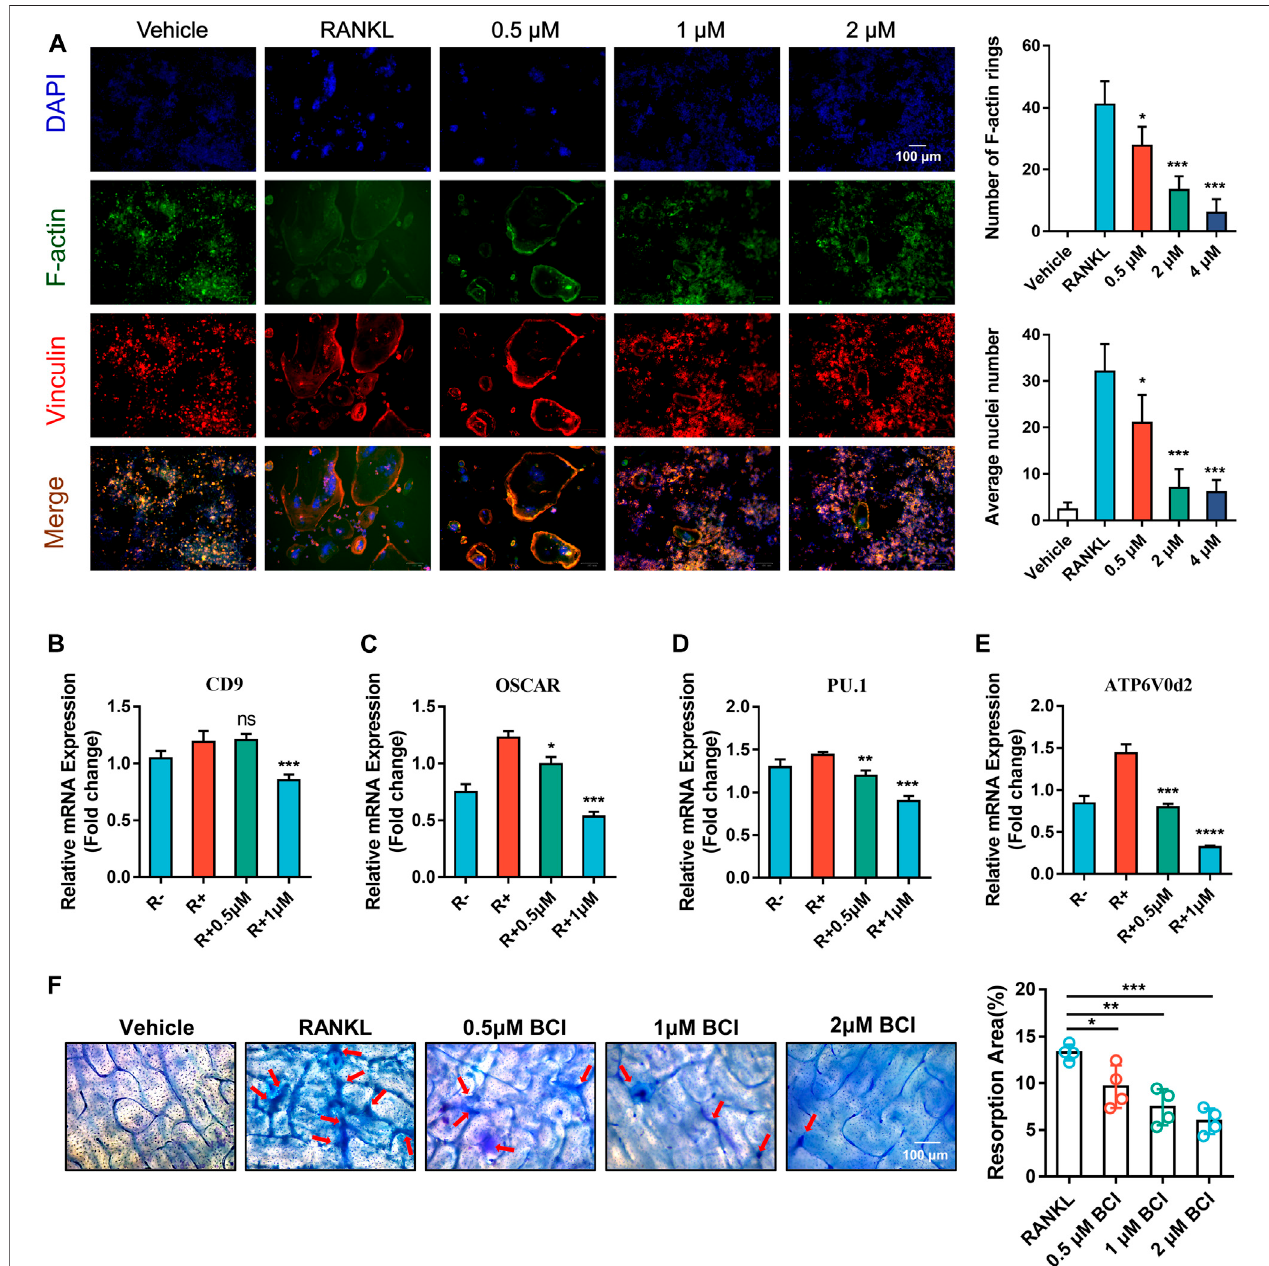
FIGURE 3 | BCI inhibits RANKL-mediated osteoclast fusion and resorption. (A) Images of FAK staining of RANKL-induced RAW264.7 cells and treated with or withoutdifferentdosagesofBCI.Scalebars,100 µm. (B – E) qRT-PCRanalysisoftheexpressionofosteoclast-fusiongenes(ATP6v0d2,PU.1,OSCAR,andCD9)during RANKL-induced osteoclastogenesis in the presence of BCI. (F) Pit-formation assay assessing the effect of BCI on RANKL-induced osteoclast bone-resorption activity. Scale bars, 100 µm. The signi fi cant difference between the RANKL group and BCI-treated groups was expressed as* p < 0.05, ** p < 0.01, *** p < 0.001.